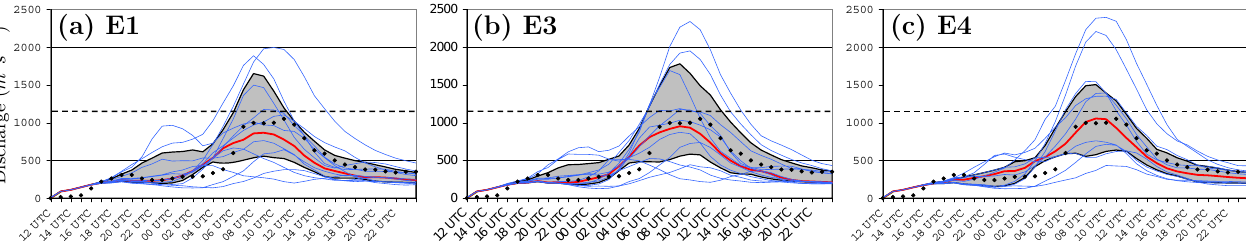
16:00 UTC 22 October 2008 at Bagnols-sur-C`eze (Fig. 14f), and 10:00 UTC 22 October 2008 at Boucoiran (Fig.